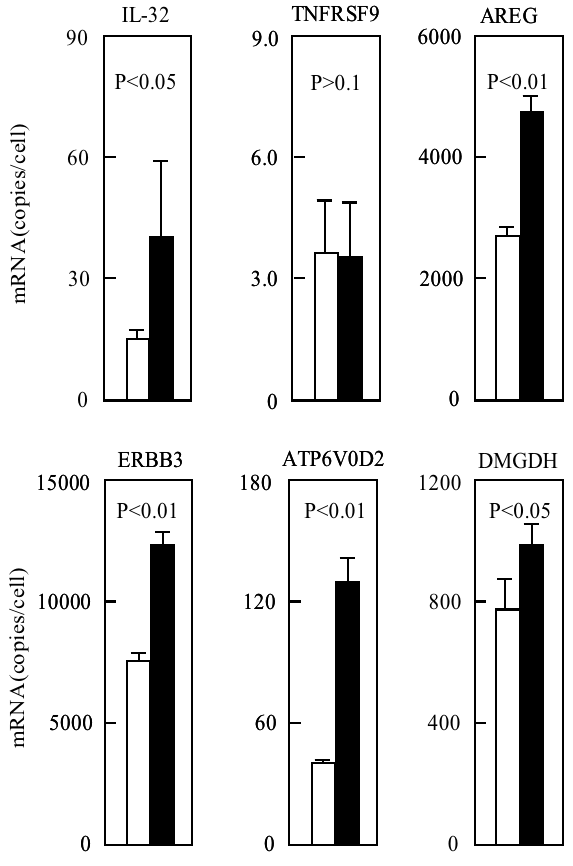
Figure 1. Gene expressions of IL-32, TNFRSF9, AREG, ERBB3, ATP6V0D2, and DMGDH at pH 7.5 and 6.7 in TE-11 cells. TE-11 cells were incubated at pH 7.5 (open bars) and 6.7 (closed bars) for 24 h. mRNA number per one cell was detected with real-time quantitative PCR. Calculation is described in Materials and Methods. The mean values and standard deviations obtained from three independent experiments are represented. P values were calculated as described in Materials and